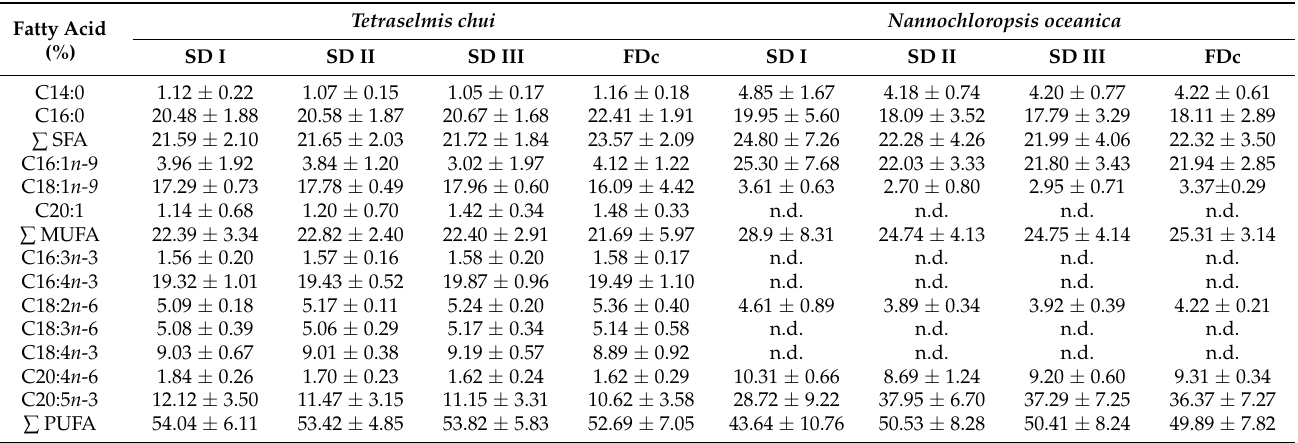
Table 3. Fatty acid profile of solar- (SD I, II, and III) and freeze-dried (FDc) Tetraselmis chui and Nannochloropsis oceanica biomass. No significant differences among samples from the same species were detected by Tukey’s post hoc range test (HSD, ANOVA). Data points for solar- and freeze-dried samples are shown as mean ± Std Dev ( n = 3). N.d., not detected; SFA, saturated fatty acids; MUFA, monounsaturated fatty acids; PUFA, polyunsaturated fatty acids.